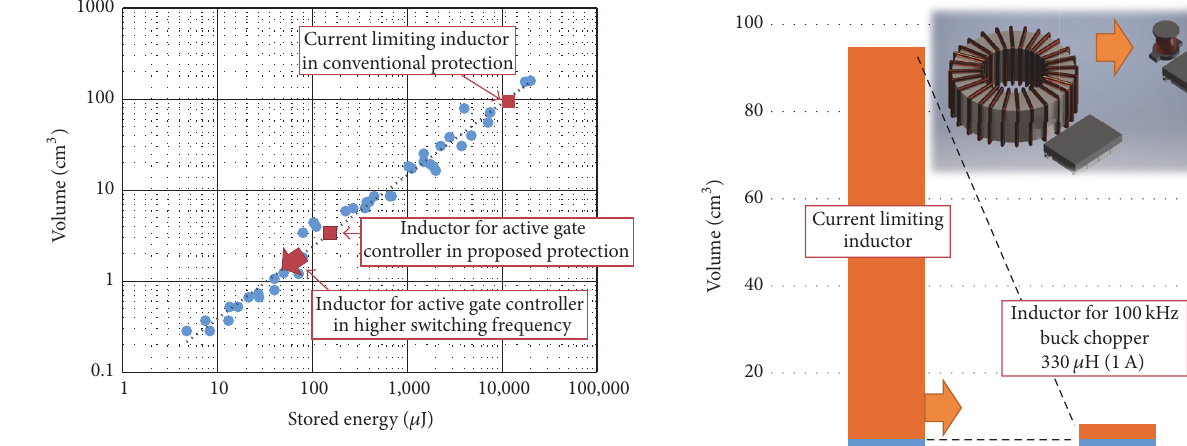
Figure 10: Relationship between inductor volume and stored inductive energy.